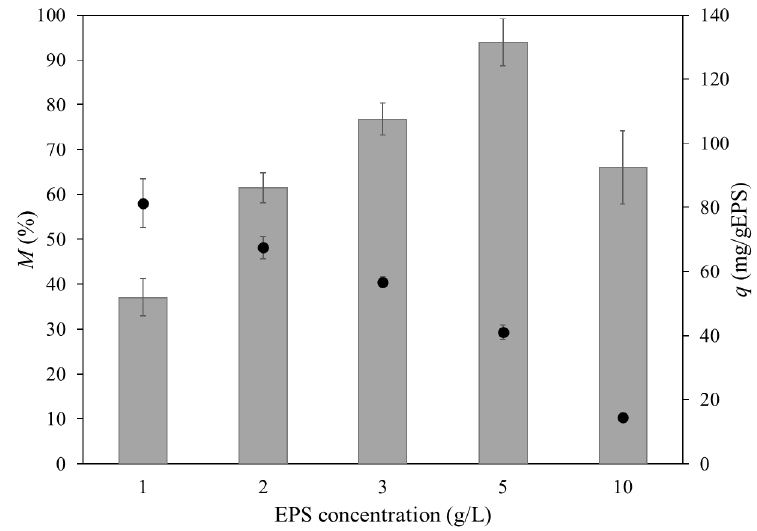
Figure 3. Removal of Pb 2+ ( C i 10 mg/L) with different FucoPol concentrations. Results presented in terms of metal uptake ( q , ● ) and removal efficiency ( M , ) (pH 4.3, temperature 21 °C, incubation time 24 h).